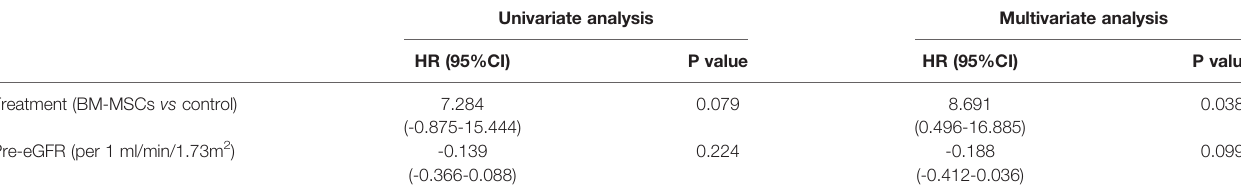
TABLE 4 | Effect of BM-MSCs treatment on delta eGFR at two